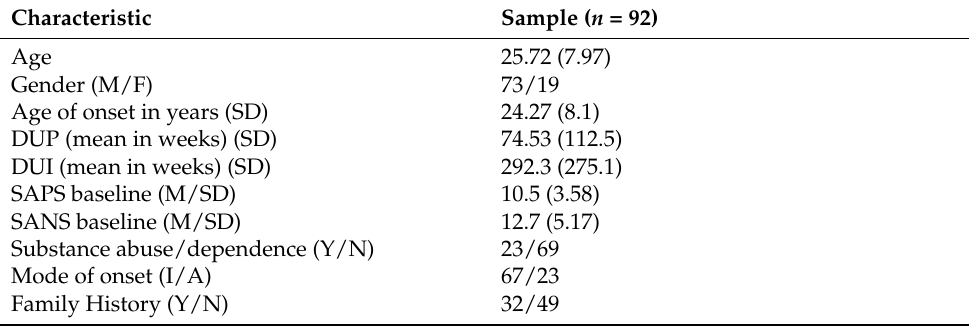
Table 1. Clinical and demographic characteristics of the final